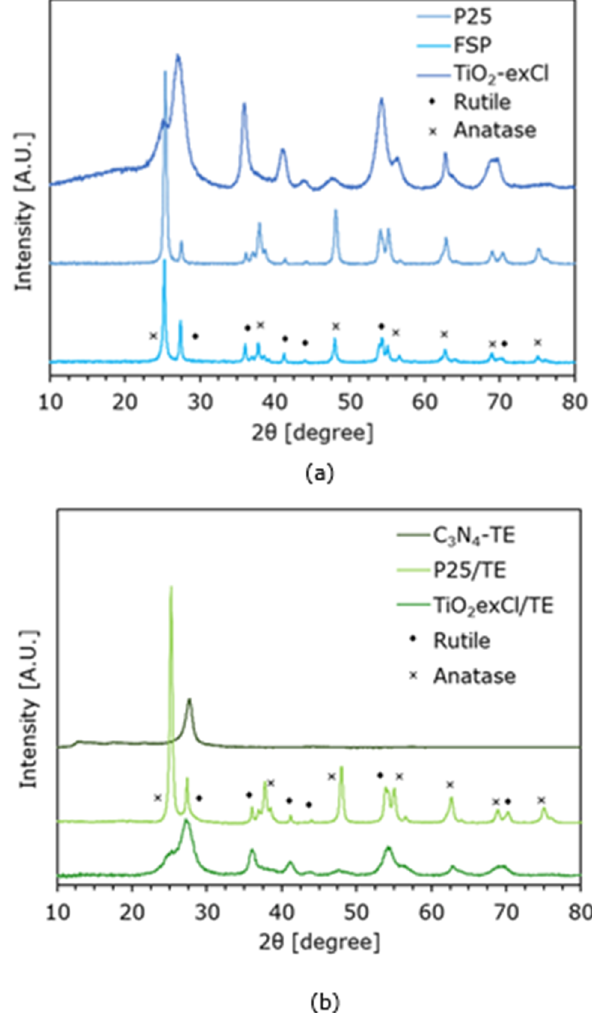
Figure 1. XRD diffractograms of all of ( a ) TiO 2 photocatalysts and ( b ) bare C 3 N 4 and TiO 2 /C 3 N 4 com- posites. The cross and the square indicate the main reflections of anatase and rutile phases, respec- tively.